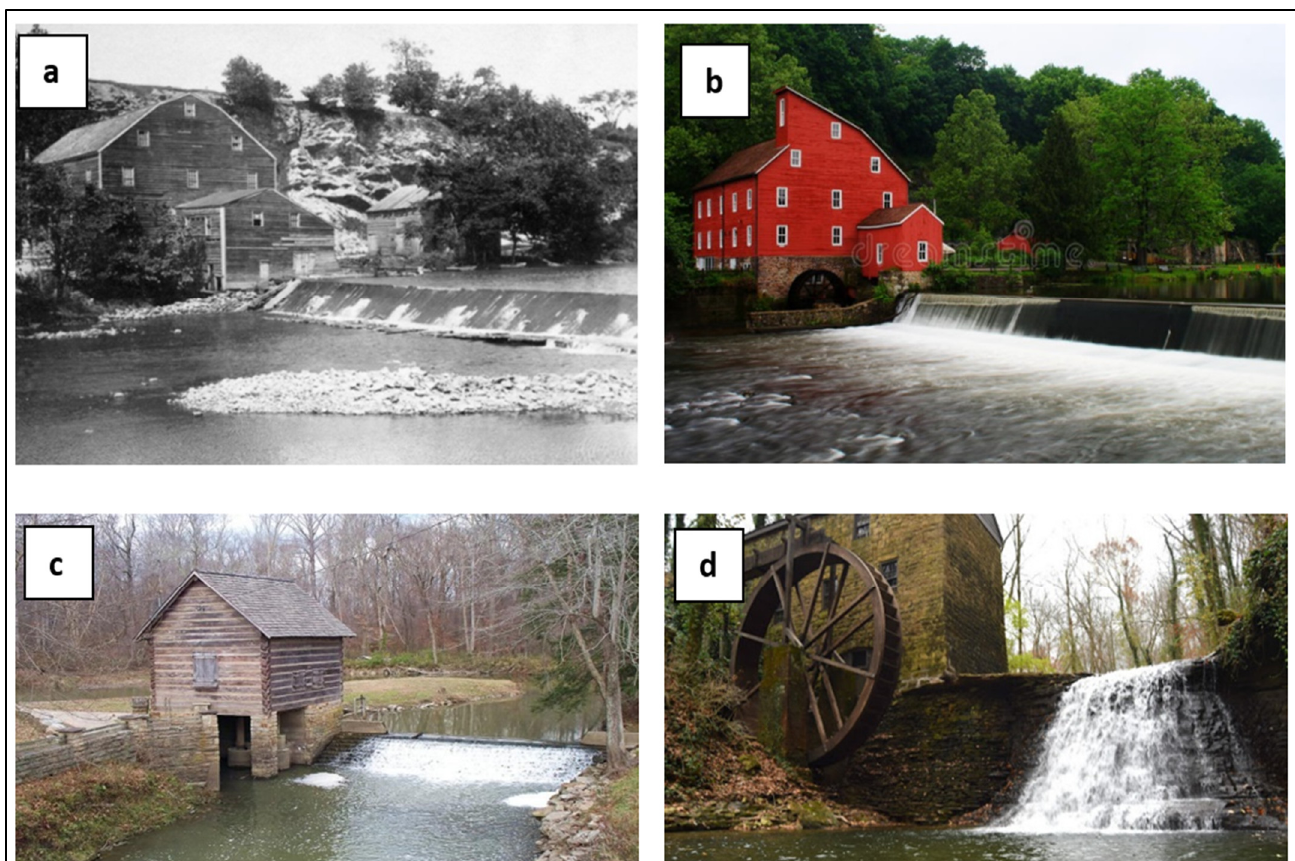
Figure 19. American water mills: ( a ) the Red Water mill in 1810; ( b ) the Red Water mill today; ( c ) McHargues’ water mill in Knox County, Kentucky (photo by Robert T. Kinsey); ( d ) Wolf Pen Branch Mill in Louisville, Kentucky (photo by Michael C. Wells).